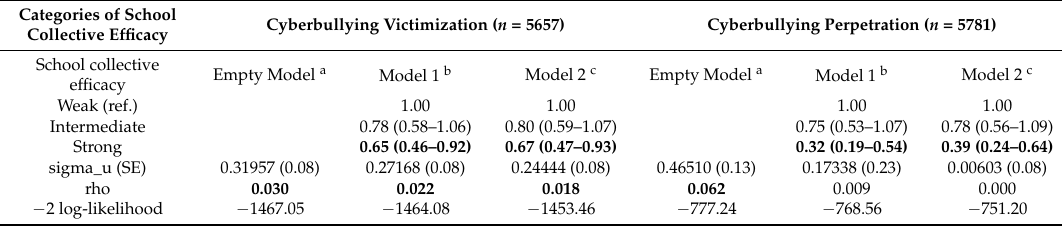
Table 5. Cyberbullying victimization and perpetration regressed on school collective efficacy. Results from two-level binary logistic random intercept models. Odds ratios and 95% (CI)